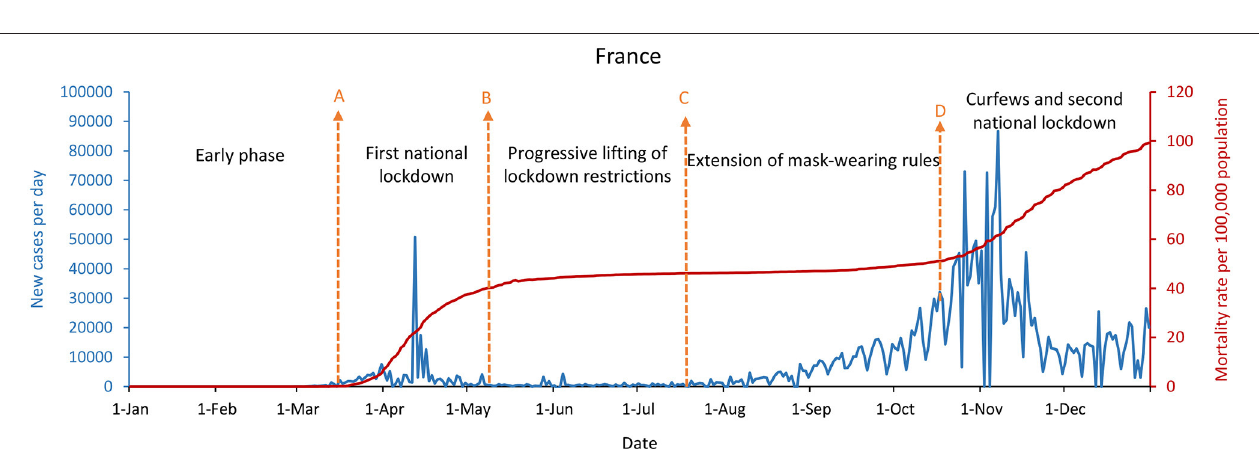
FIGURE 5 | The United Kingdom’s COVID-19 epidemic curves and population mortality rate (between January 1 and December 31, 2020). (A) Starting in March 2020, closures and restrictions. Closures and cancelations in March, lockdown continues in April, and lockdown easing begins. (B) Starting in June 2020, continued restrictions and local lockdowns. Requiring individuals to self-isolate for 14 days upon arrival, making face masks compulsory on all public transport, and delaying lockdown restrictions. (C) Starting in September, the restrictions were tightened further. (D) Starting in November, new lockdowns.